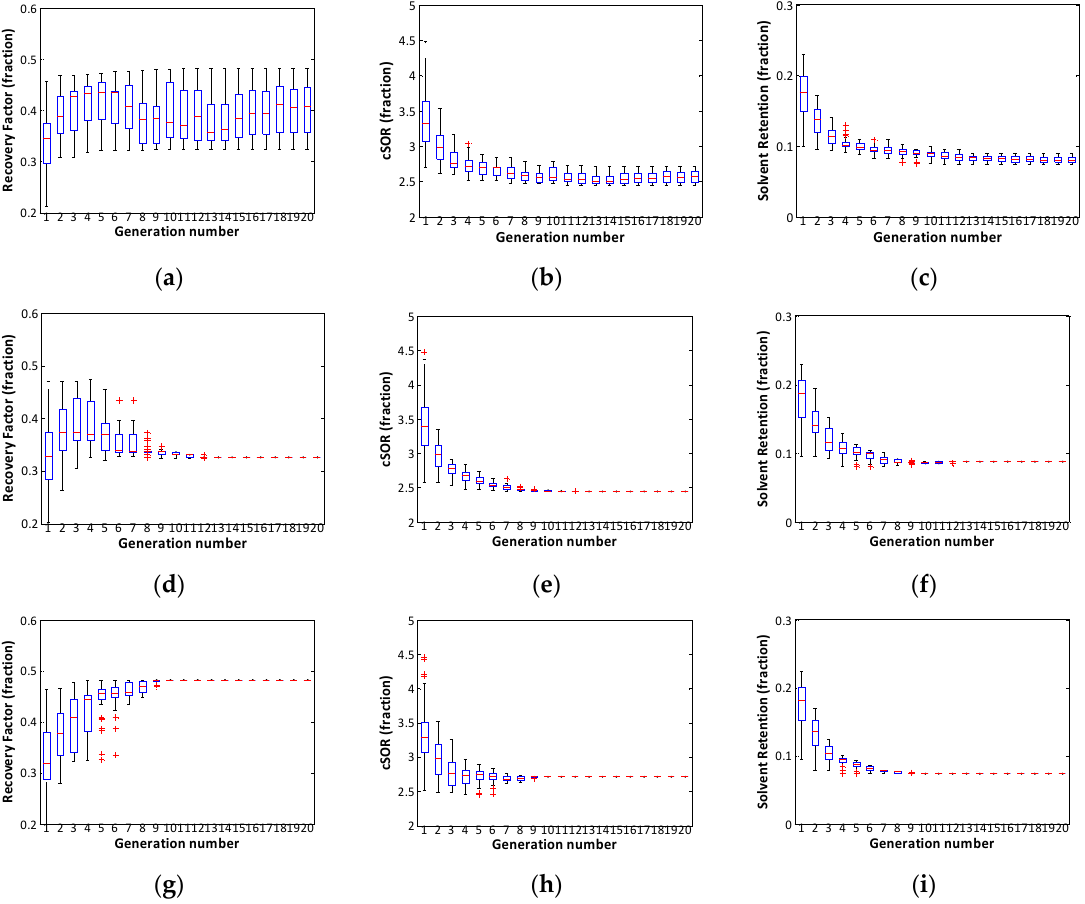
Figure 8. Evolution of performance indicators of the ES-SAGD process obtained by running global- and multi-objective optimization algorithms: ( a ) Recovery Factor (RF) obtained by invoking NSGA-II; ( b ) Cumulative Steam–Oil Ratio (cSOR) by invoking NSGA-II; ( c ) Solvent Retention (SR) by invoking NSGA-II; ( d ) RF obtained by invoking GA with Equation (12); ( e ) cSOR obtained by invoking GA with Equation (12); ( f ) SR obtained by invoking GA with Equation (12); ( g ) RF obtained by invoking GA with Equation (13); ( h ) cSOR obtained by invoking GA with Equation (13); and ( i ) SR obtained by invoking GA with Equation